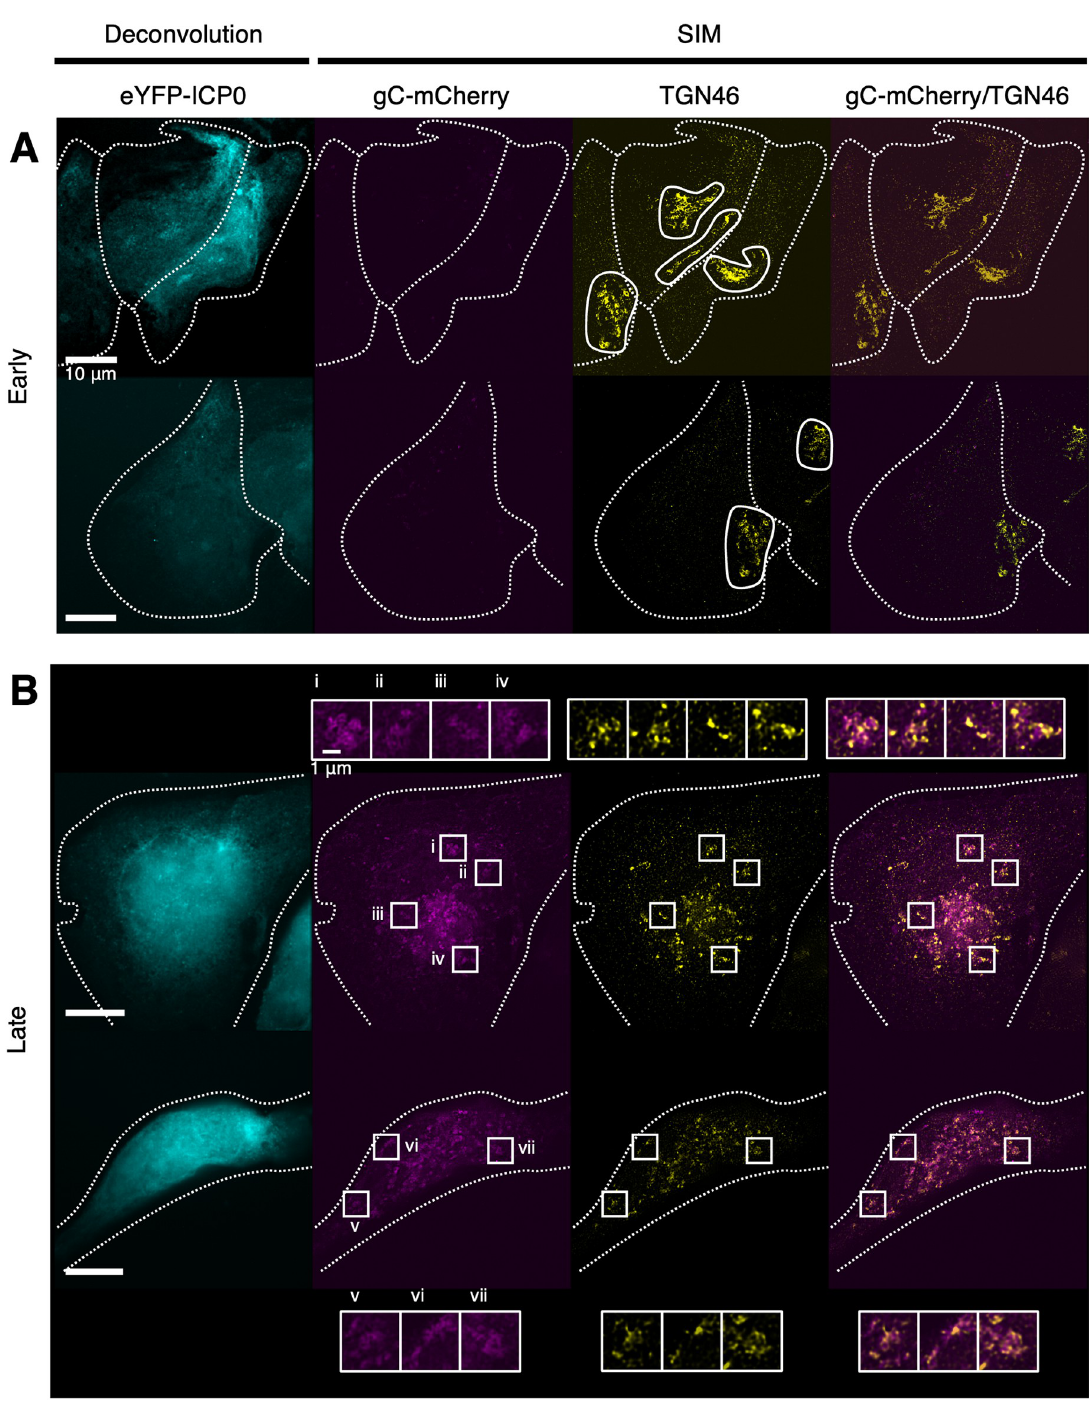
Fig 7. Fragmentation and dispersal of trans -Golgi membranes during HSV-1 infection. U2OS cells infected (MOI 3) with timestamp HSV-1 were fixed 6 hpi and imaged by SIM and deconvolution microscopy. TGN46 immunolabelling was used to identify trans -Golgi network membranes [108]. Dotted outlines denote the cell boundaries. (A) Cells at early stages of infection were identified by the presence of eYFP-ICP0 signal using deconvolution microscopy and by the absence of high gC-mCherry signal using SIM. TGN46 + membranes, which appeared both clustered and dispersed at early stages of infection, are outlined. (B) Cells at late stages of infection were identified by the presence of high gC-mCherry signal using SIM and TGN46 + membranes were widely dispersed in these cells. Boxes (i–vii) and corresponding insets indicate sites of colocalization and adjacent signal between TGN46 and gC-mCherry.